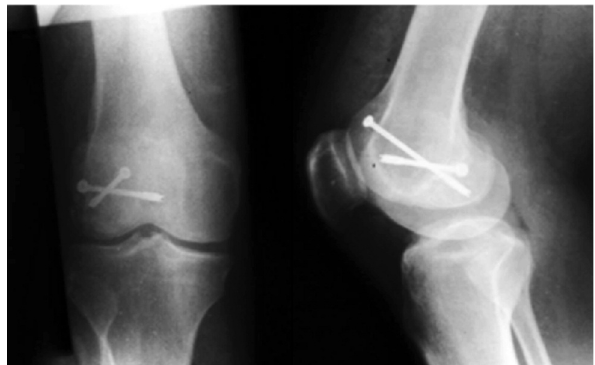
Radiographs at 12 months follow-up showing fixation of Fig. 3: fracture with two screws.